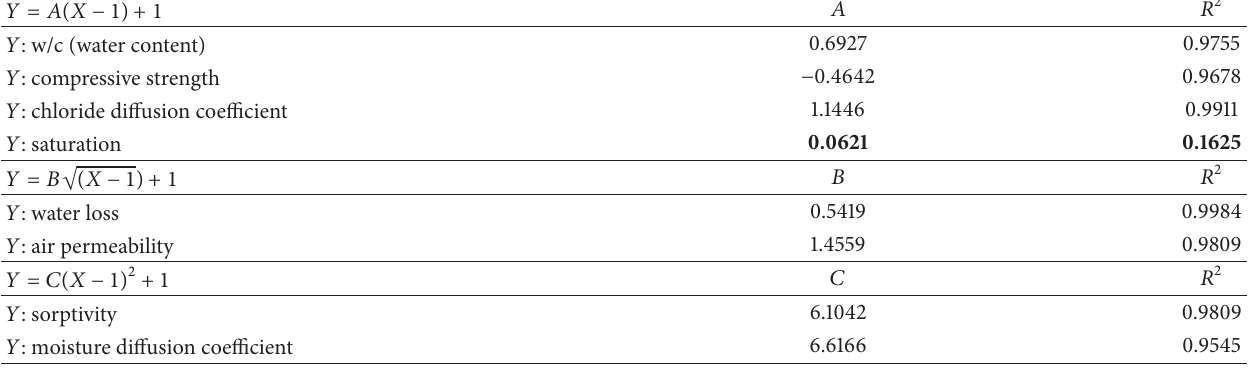
Table 7: Results of regression analysis for normalized porosity and durability performance.